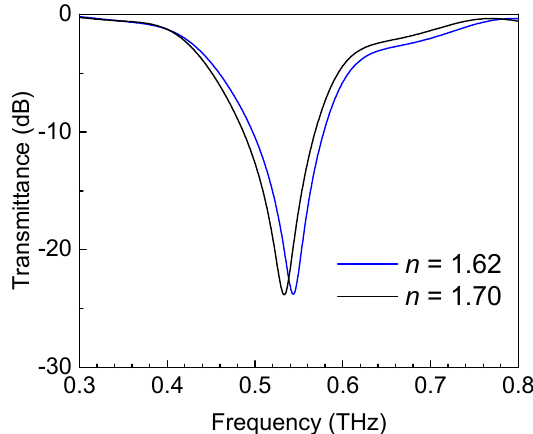
Figure 7. Simulated terahertz spectra of metamaterial-coated LC cells filled with E7 LC at n = 1.62 and 1.70.